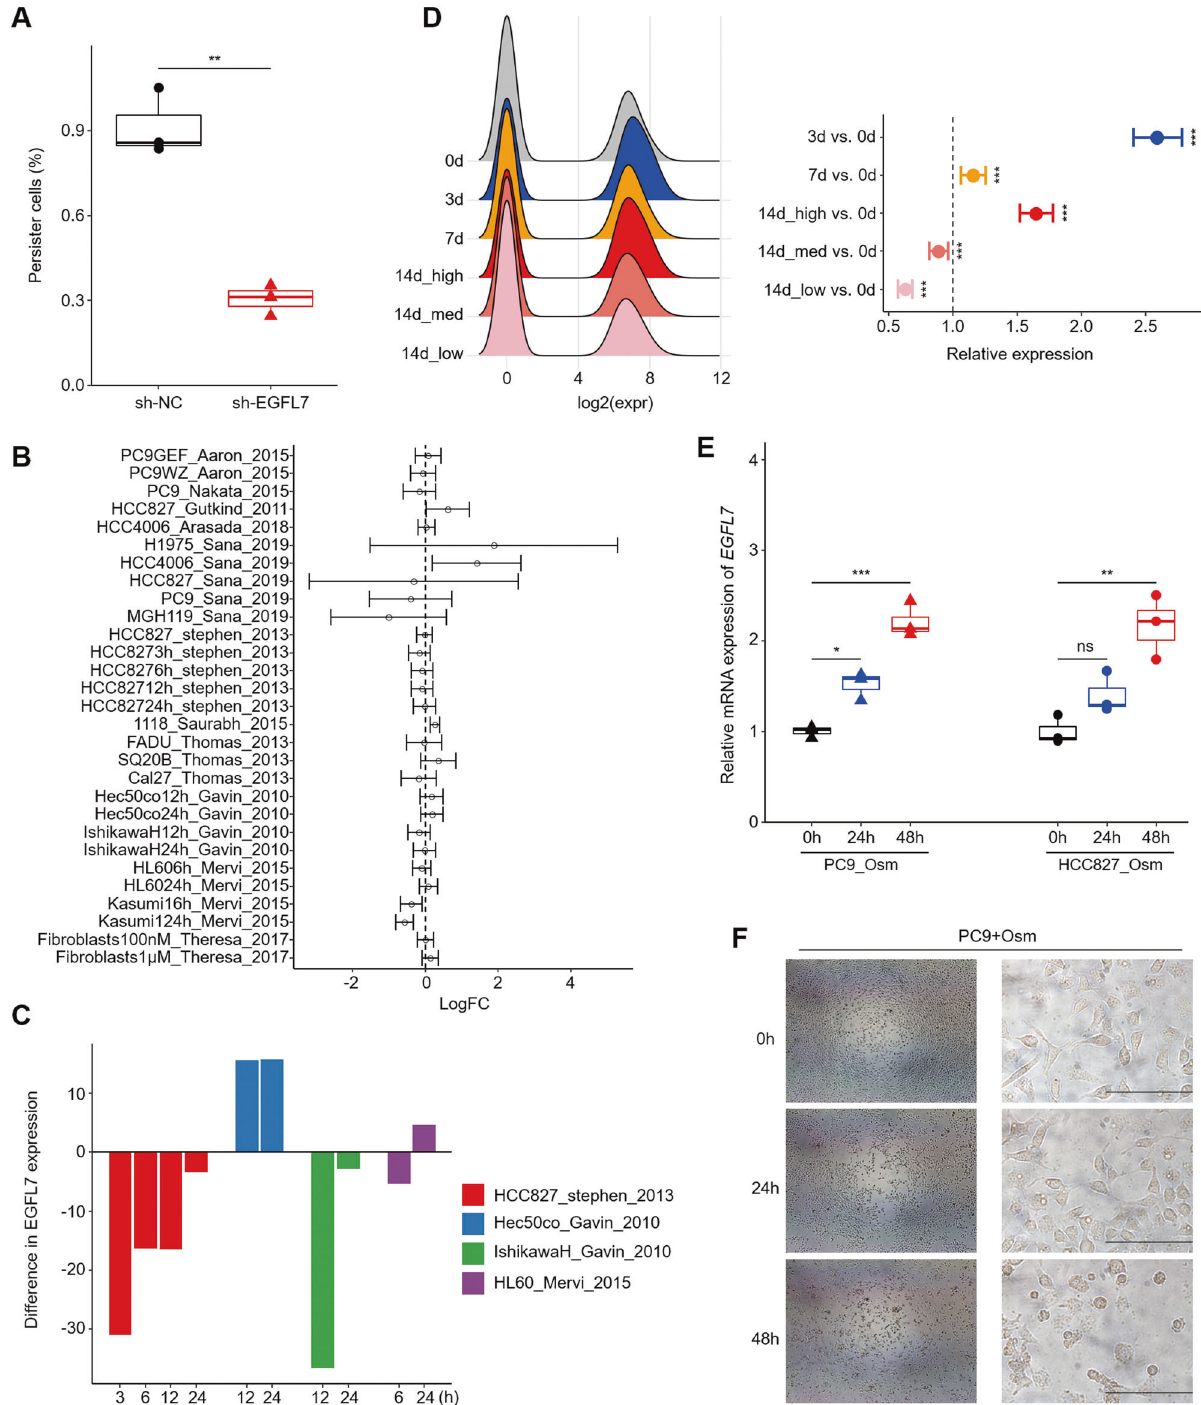
Fig. 3 Validation of EGFL7 as a late response gene to EGFR kinase inhibition. A The proportion of PC9 cells remained after a 9-day osimertinib treatment to seeding number. The median line represents median values. The top and bottom of box are 25th and 75th percentiles. B Relative expression of EGFL7 in cancer cells treated with EGFR inhibitors to the control in indicated studies. Dashed line presents no change (fold change equal to 1). Point and error bars present mean value and 95% con fi dence interval (see methods). C Difference in EGFL7 expression upon different treatment duration of EGFR inhibitors in the indicated datasets from B . D Relative EGFL7 expression in groups of PC9 single cells (GSE150949, see methods). Dashed line presenting no change (fold change equal to 1) in right panel. E Relative EGFL7 expression in PC9 and HCC827 cells treated with osimertinib for the indicated time duration. Point and error bars present mean value and 95% con fi dence interval in D and mean ± standard error of the mean (SEM) in E . p values are calculated by MAST package ( D ). F Representative light microscopic images of PC9 upon different osimertinib treatment duration. Scale bar: 200 µm. p values are calculated by two-tailed Student ’ s t test (ns, p > 0.05; * p < 0.05; ** p < 0.01; *** p < 0.001) otherwise speci fi ed.